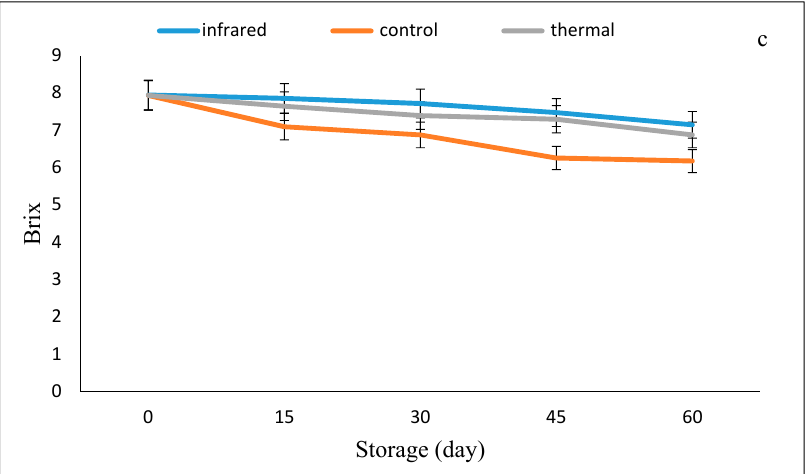
Figure 2. ( a ) The pH, ( b ) titratable acidity (TA), and ( c ) Brix (solids) of the infrared treated juice samples, the thermally treated samples (conventional), and the control sample during storage for 60 days at a temperature of 5 °C. The results also indicated a decrease in the Brix values of the infrared treated juice samples and the thermal samples (conventional) and the control sample. The results ob- tained were in agreement with Kaddumukasa et al. [36] who indicated that the decrease was likely due to microbial activities that led to the conversion of sugars in the samples into organic acids and thus caused a decrease in the pH, Brix values and the reduction of the shelf life of the product. The results of the statistical analysis indicated that there were significant differences between the samples of juice treated with infrared radiation com- pared to the control samples and the samples of thermal (conventional) for each of the values of pH, acidity, and Brix. The results of the statistical analysis indicated that there was a significant difference ( p < 0.05) between samples thermal samples (conventional) and the control sample for pH, acidity, and Brix values.